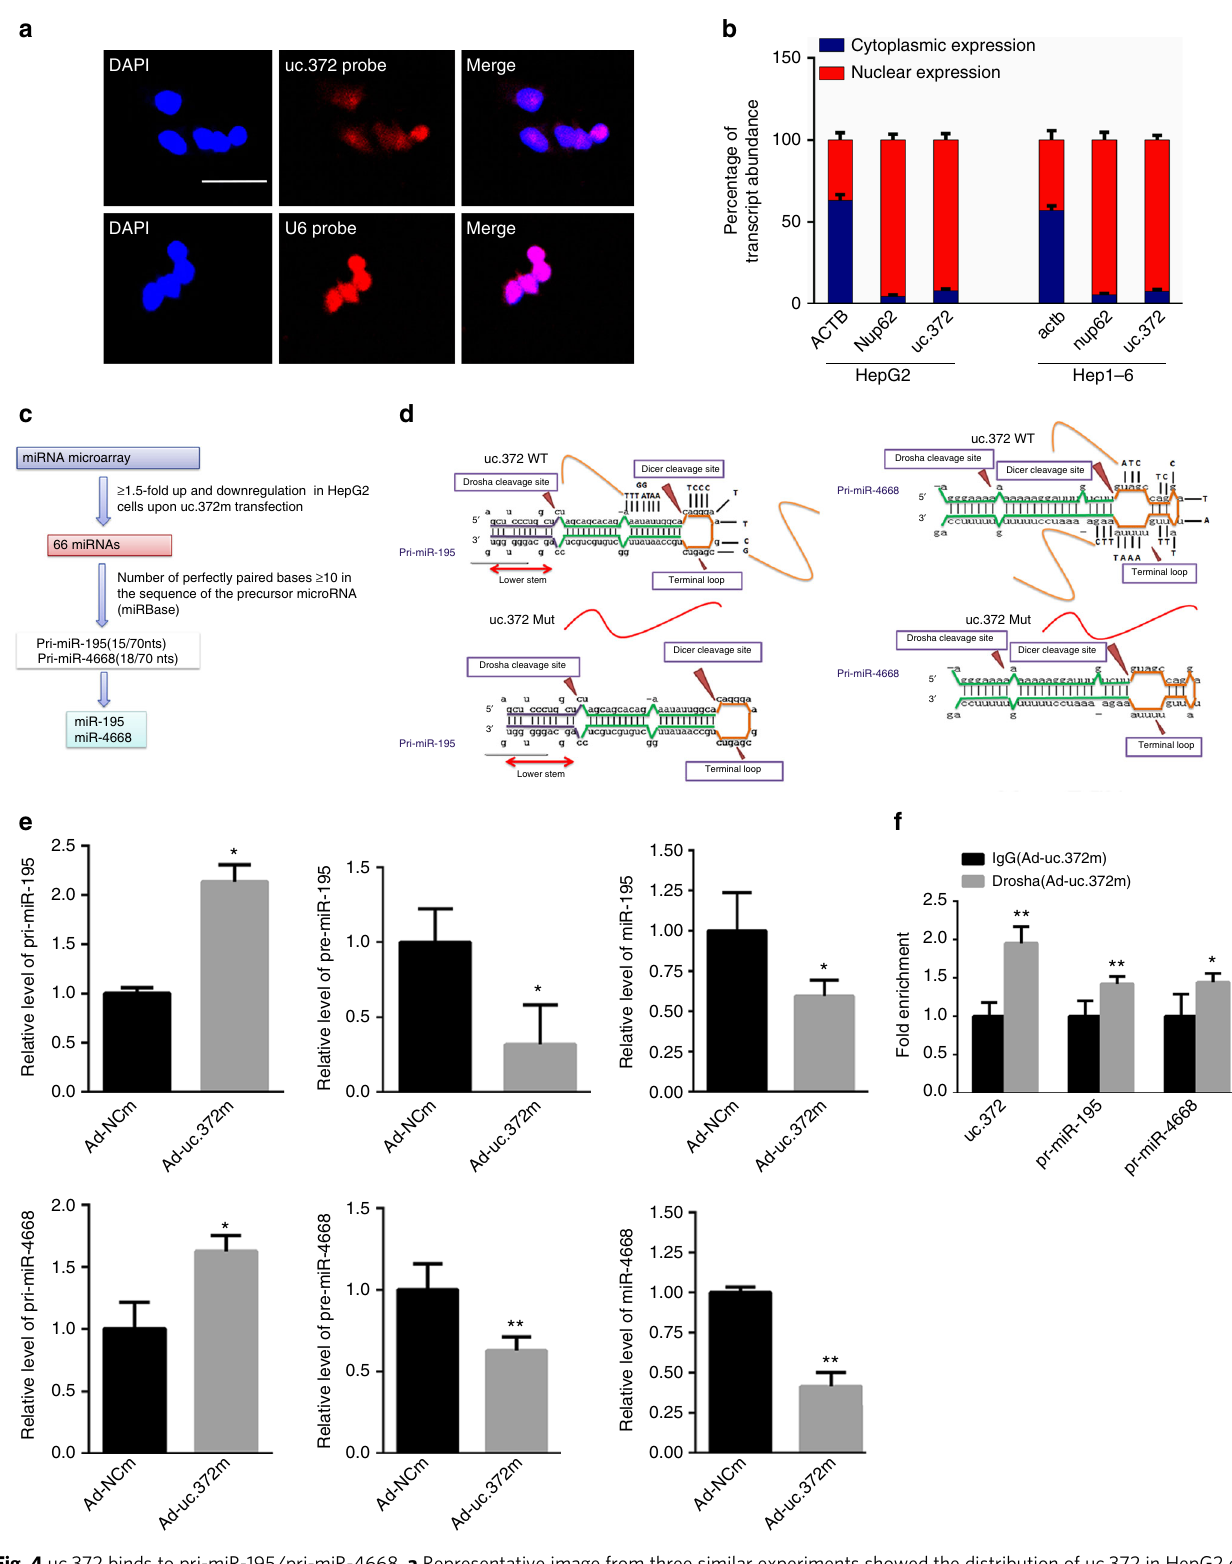
Fig. 4 uc.372 binds to pri-miR-195/pri-miR-4668. a Representative image from three similar experiments showed the distribution of uc.372 in HepG2 cells as analyzed by in situ hybridization. Scale bar, 25 μ m. b Cellular fractionation assay in HepG2 and Hep1-6 cells was performed by quantitative real-time PCR using a speci fi c cytosol control (gene ACTB ) and a speci fi c nuclear control (gene Nup62 ) ( n = 3). c Schematic fl owchart depicting the strategy. d The stem-loop sequence of pri-miR-195 (left panel) and pri-miR-4668 (right panel), and their partial complementarity with uc.372. e The levels of pri-miR-195/ pri-miR-4668, pre-miR-195/pre-miR-4668, and mature miR-195/miR-4668 in the HepG2 cells transfected with Ad-uc.372m or Ad-NCm for 48 h ( n = 3). f RIP assay showed that uc.372 could bind pri-miR-195/pri-miR-4668 in HepG2 cells transfected with Ad-uc.372m or Ad-NCm for 48 h ( n = 3). Data are mean ± SEM; * P < 0.05; ** P < 0.01 vs. control group (Student ’ s t